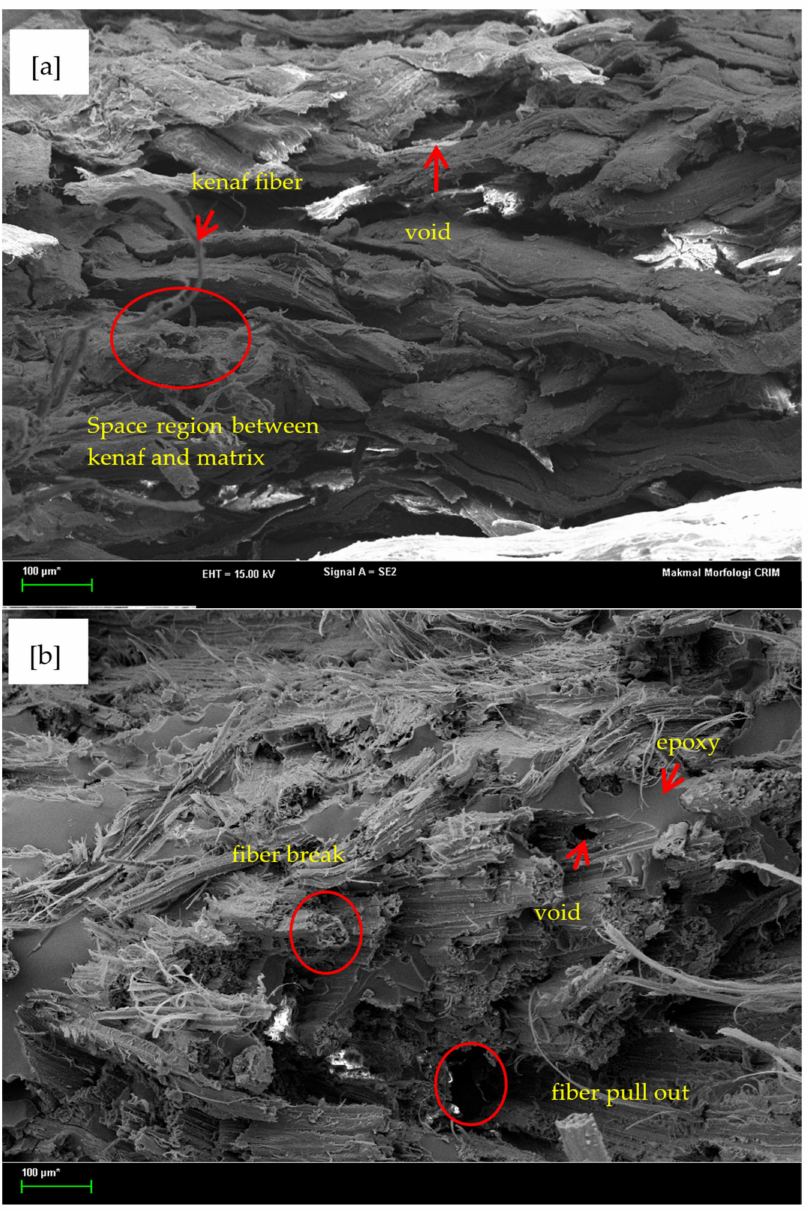
Figure 13. SEM image (100 × magnification) of epoxy composite reinforced with; ( a ) untreated kenaf fiber and ( b ) treated kenaf